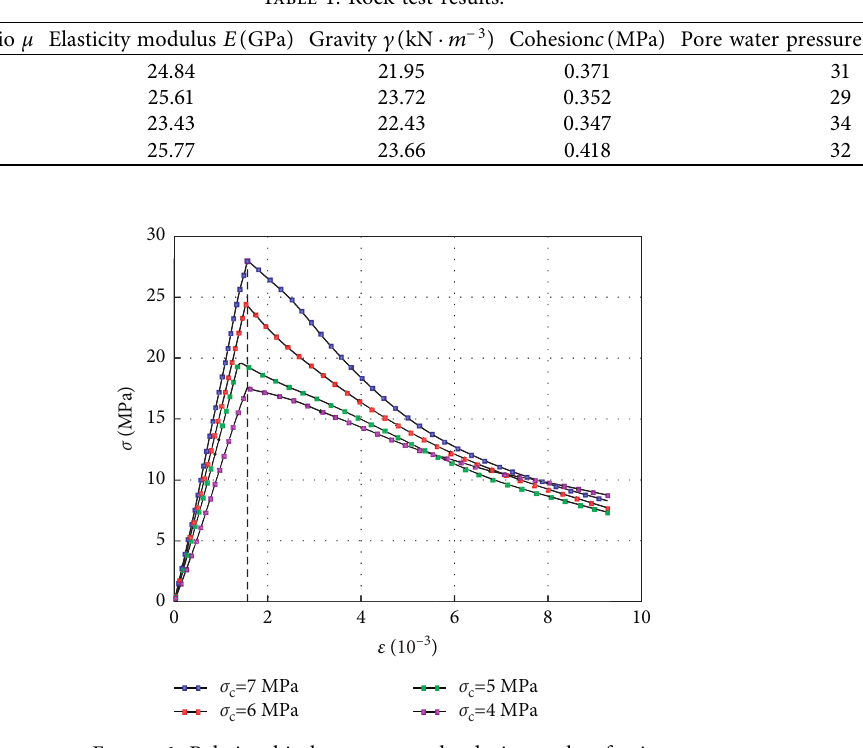
Figure 1: Relationship between σ and ε during rock softening.